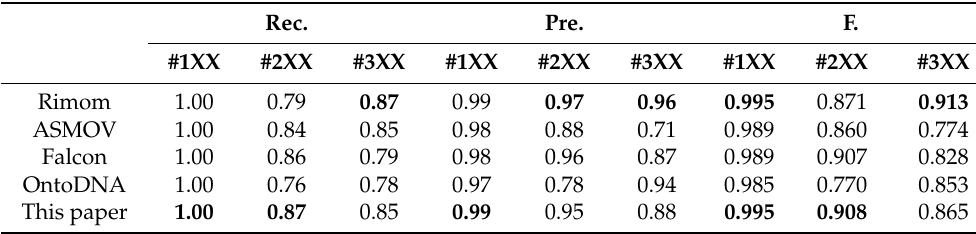
Table 10. Experimental results based on OAEI data set. Rec. Pre.